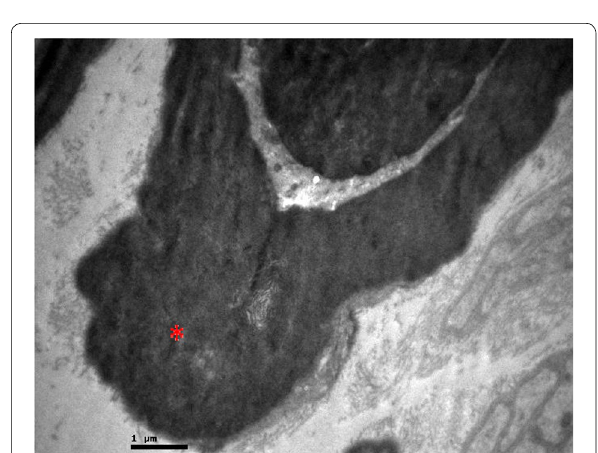
Fig. 2 Research group: myelin thickening (red